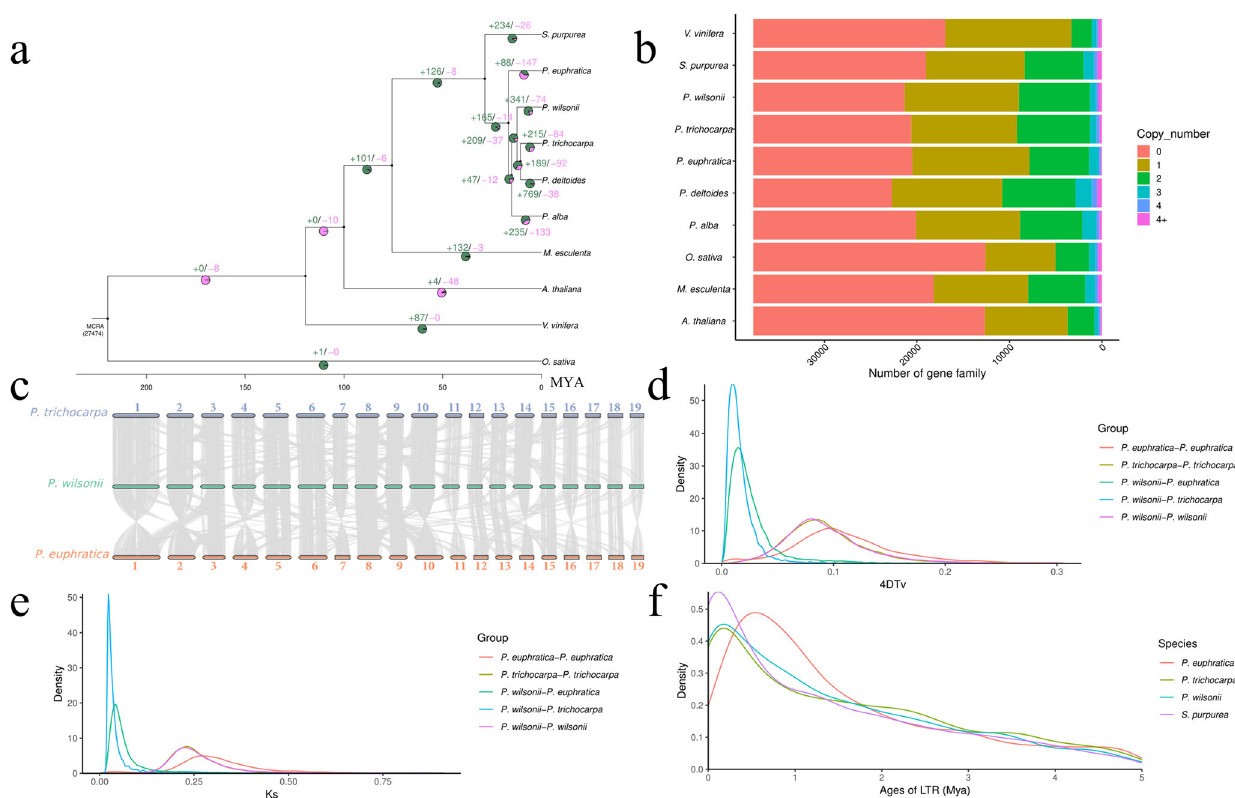
Fig. 2 Evolution of Populus wilsonii and Relative Species in Salicaceae . a Phylogenetic tree of 9 species and Populus wilsonii . Gene family expansion and contraction compared with the most recent common ancestor. Gene family expansions/contractions are indicated in Cyan/purple. Inferred divergence times (MYA, million years ago) are denoted at each node. Venn diagram shows the ratio of gene family expansions and contractions. b Gene categories used from all the species (the resource of this fi gure is from Supplementary Data 5). c Syntenic blocks between Populus wilsonii , P. trichocarpa and P. euphratica . d Distribution of 4DTV values of syntenic orthologous genes in the genomes of Populus wilsonii, P. trichocarpa and P. euphratica . e Distribution of Ks values of syntenic orthologous genes in the genomes of Populus wilsonii, P. trichocarpa and P. euphratica . f Insertion time of LTRs in Populus wilsonii, P. trichocarpa , P. euphratica and S. purourea